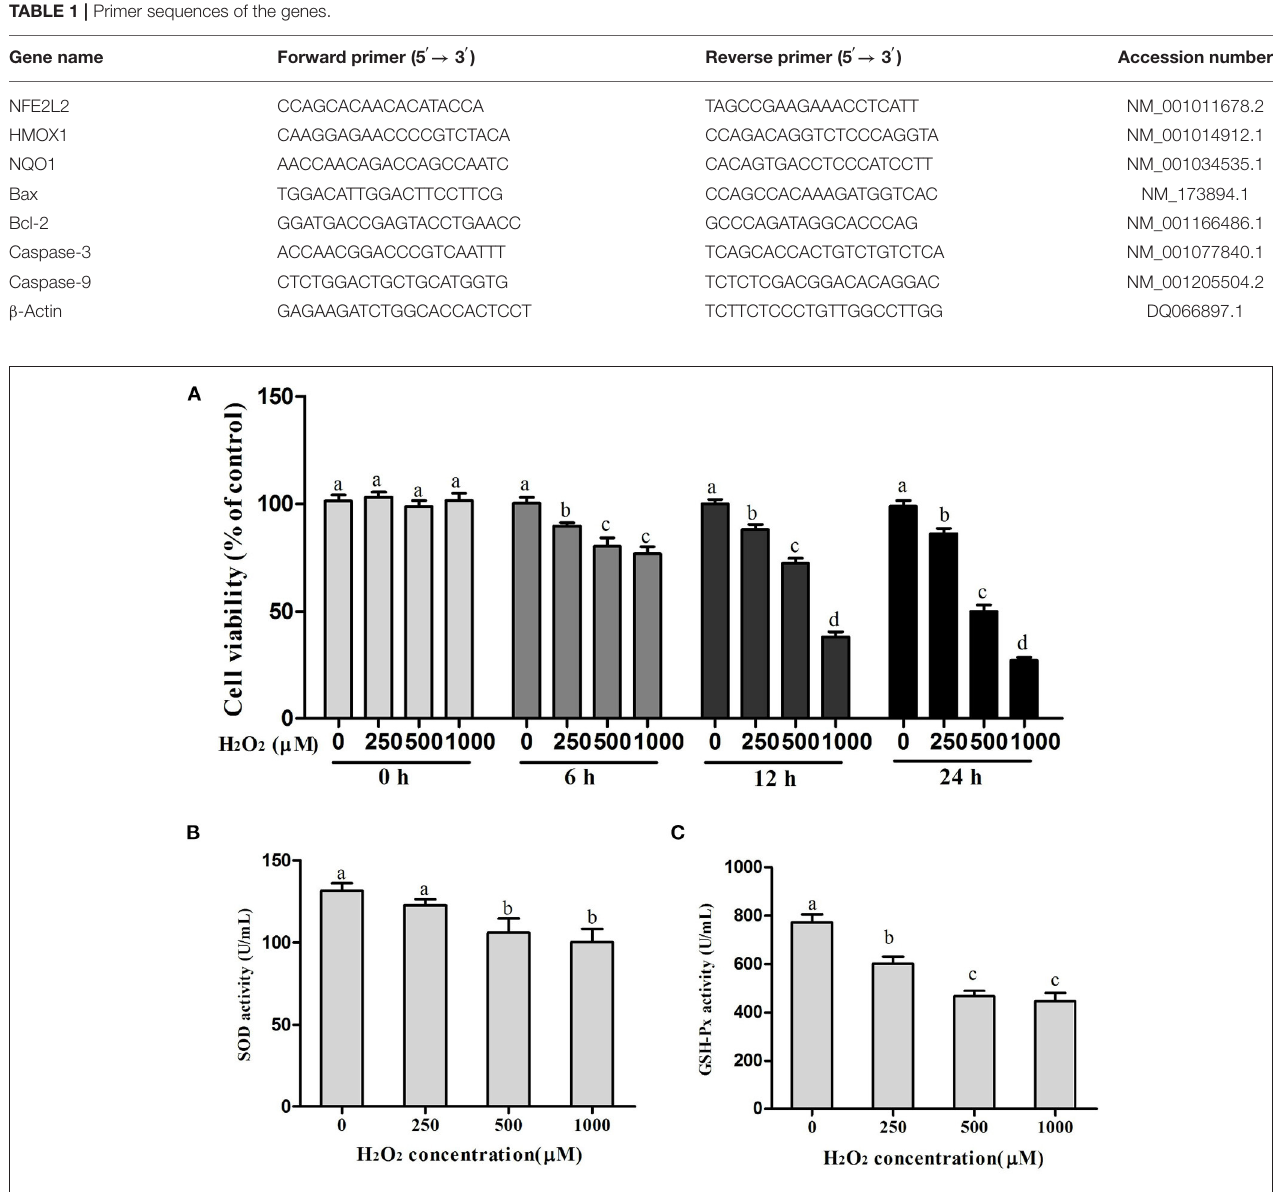
FIGURE 1 | Selection of the optimum conditions for H 2 O 2 treatment. (A) Cell viability in BMECs, (B) SOD activity, and (C) GSH-Px activity. a,b,c,d, the adjacent lowercase letters indicate significant difference, the alternate lowercase letters indicate extremely significant difference, and the same lowercase letters indicate insignificant